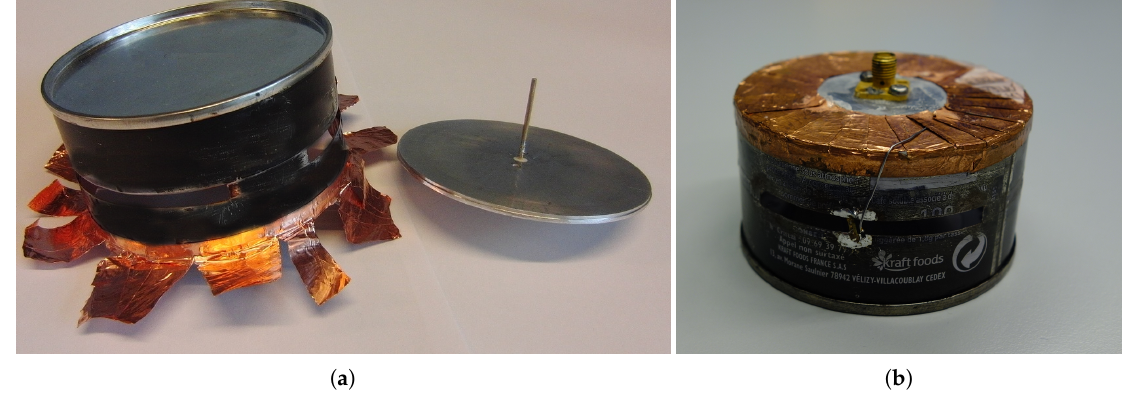
Figure 5. Pictures of the prototype. ( a ) top view ( b ) bottom view.